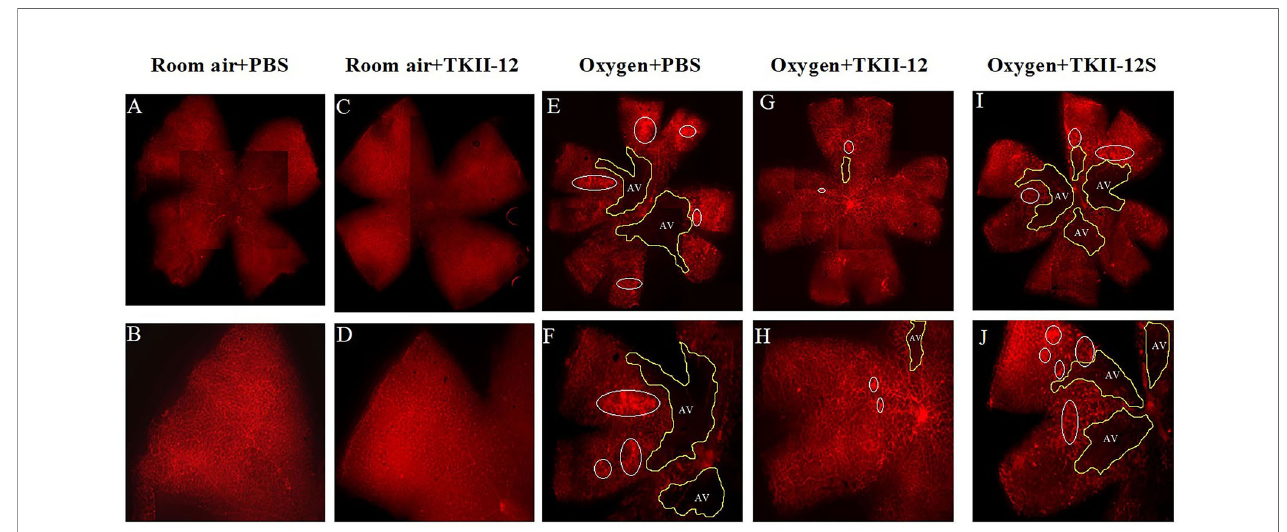
FIGURE 6 | Retina fl at-mounts stained with isolectin B4 from each group at P17. The retinal vasculature in the room air plus TKII-12 group (C, D) was no different from that of the room air plus PBS group (A, B) . Oxygen plus phosphate-buffered saline (PBS) (E, F) and oxygen plus the scrambled peptide (G, H) groups exhibited a remarkable avascular region and pathologic neovascular tufts. Oxygen plus TKII-12 group (I, J) showed a signi fi cant reduction in neovasculature and avascular region. Top row: whole retina montages created by four overlapping images containing one quadrant each; bottom row: a single image of the whole fl at- mount, showing one quadrant. White circle: neovascular tufts. Yellow area: avascular region. Magni fi cation,